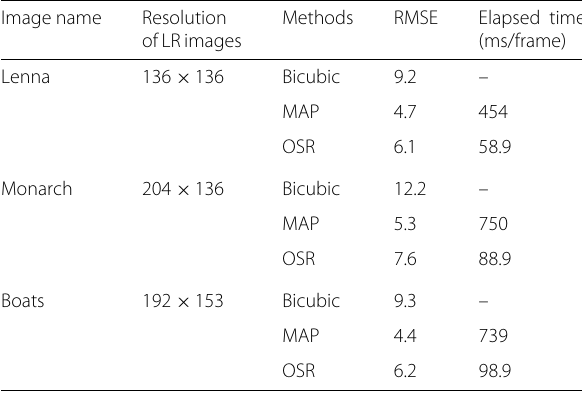
The RMSE of bicubic-interpolated images is the average of 15 bicubic-interpolated images. The SR scales are all set to